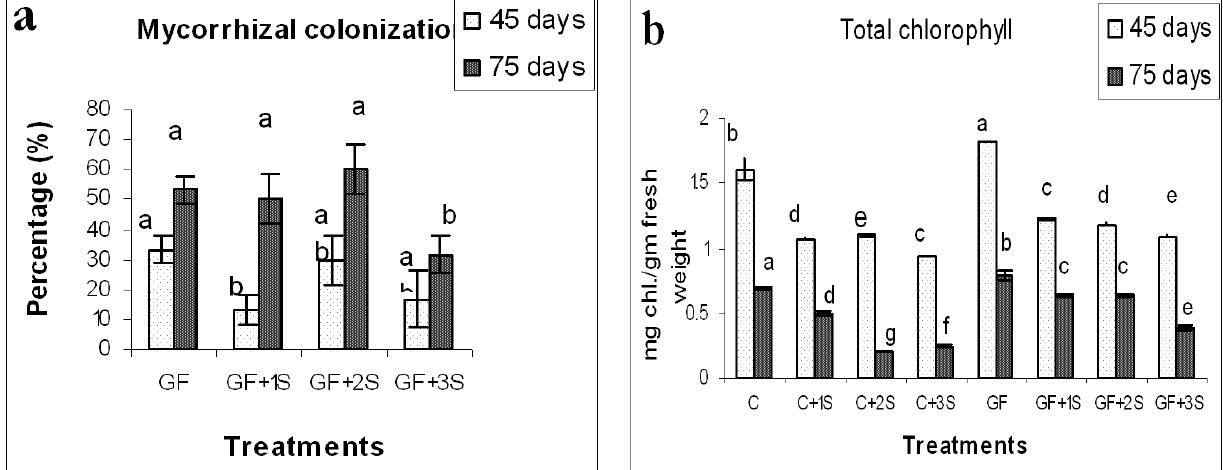
Fig. 1. Percentage of AM colonization and Chlorophyll content of Allium sativum L. after 45 and 75 days of AM